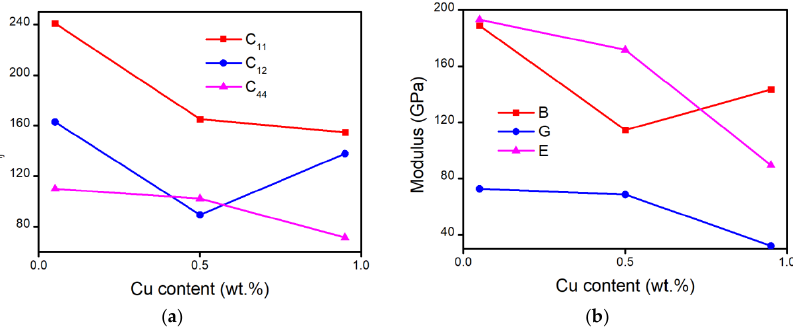
Figure 3. Cu content ‐ dependent mechanical properties: ( a ) elastic constants; ( b ) bulk modulus B , Shear modulus G , and Young’s modulus E .